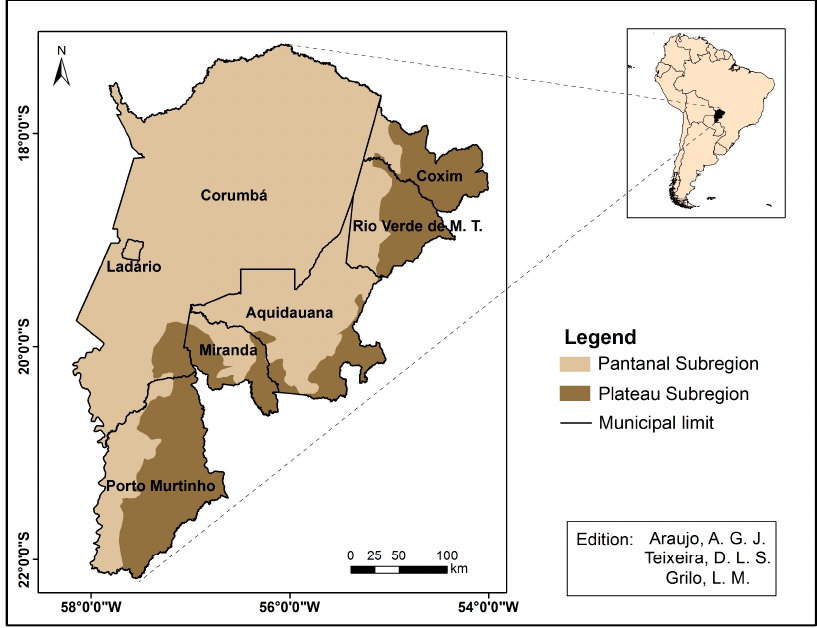
Figure 1. South Pantanal area. Source: Adapted from Silva and Abdon (1998).